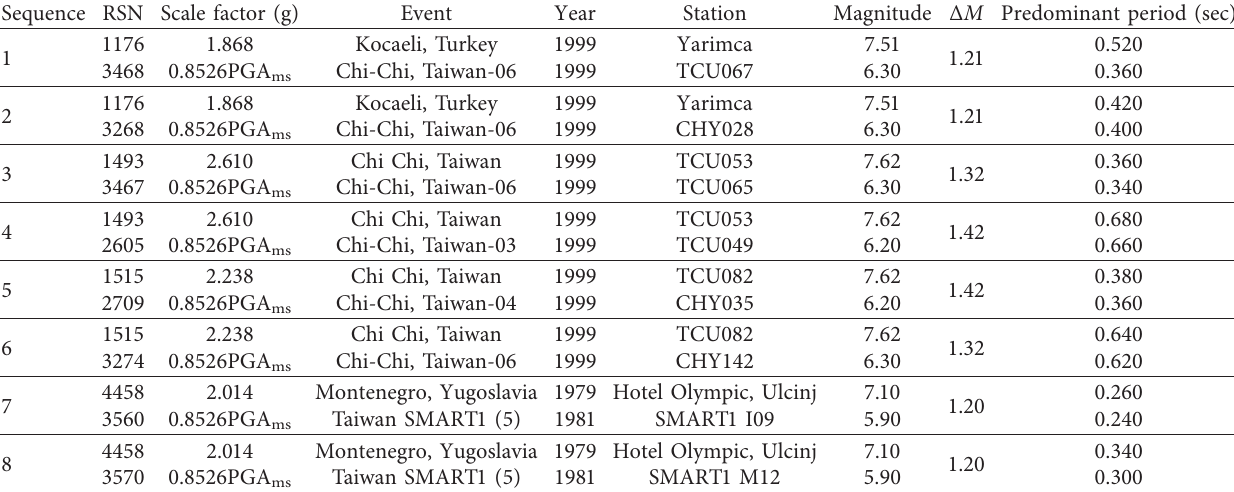
Table 3: Combinations of seismic